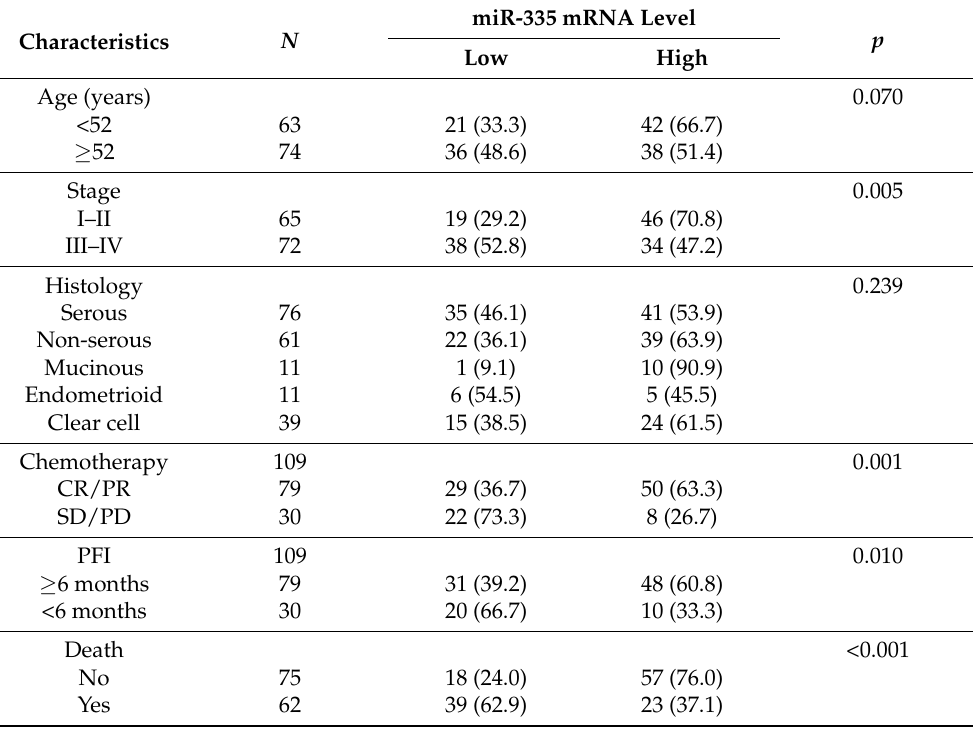
Table 1. Correlations between miR-335 mRNA levels and patient demographic ( n =